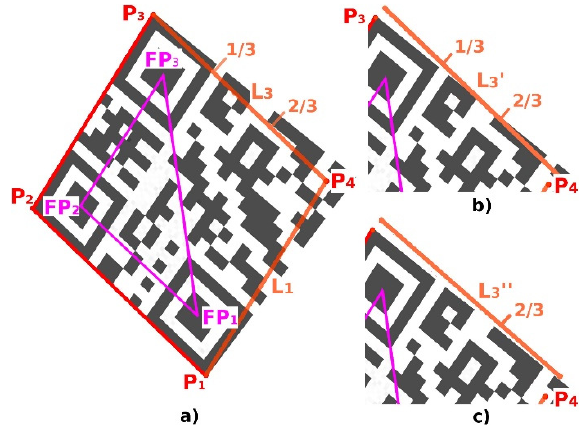
Figure 16. Perspective distortion. ( a ) initial position of the point P 4 and lines L 1 , L 3 ; ( b ) first shift of the line L 3 ; ( c ) second shift of the line L 3.